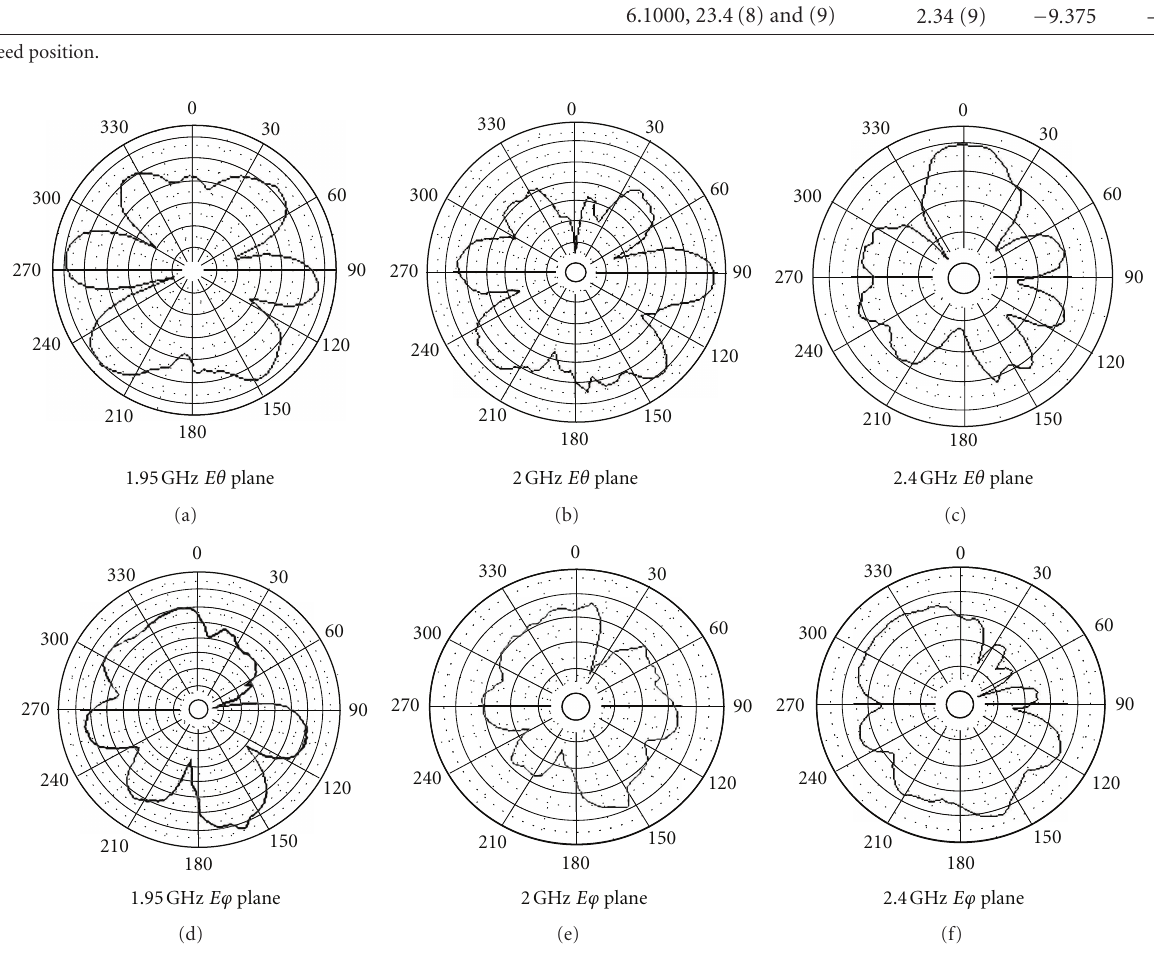
Figure 6: Measured radiation pattern for Eθ and Eϕ planes for 1.95 GHz, 2 GHz, and 2.4